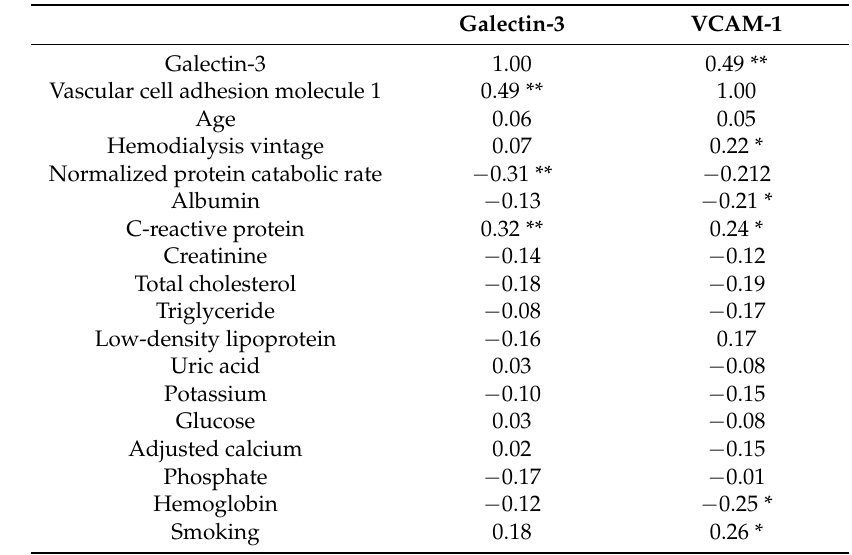
Table 2. The correlation analysis in galectin-3, VCAM-1, and clinical parameters of